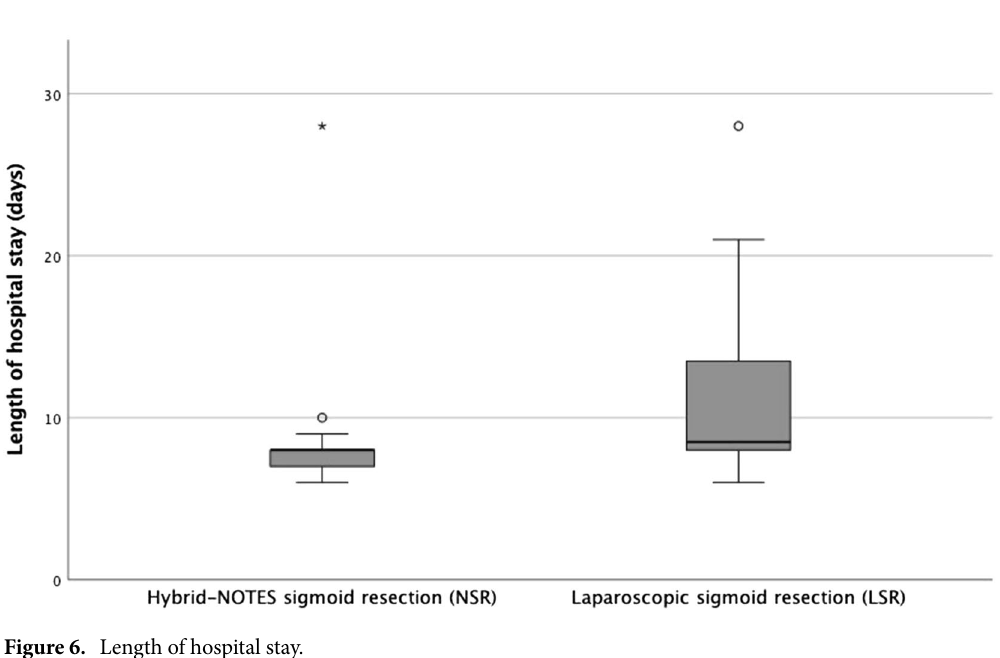
Figure 6. Length of hospital